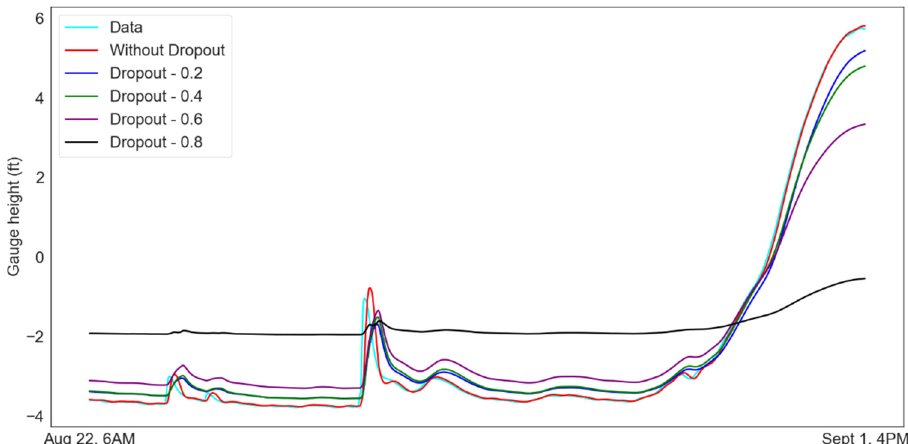
Figure 6. Test predictions with variation in dropout . Table 5. LSTM performance with variation in dropout.